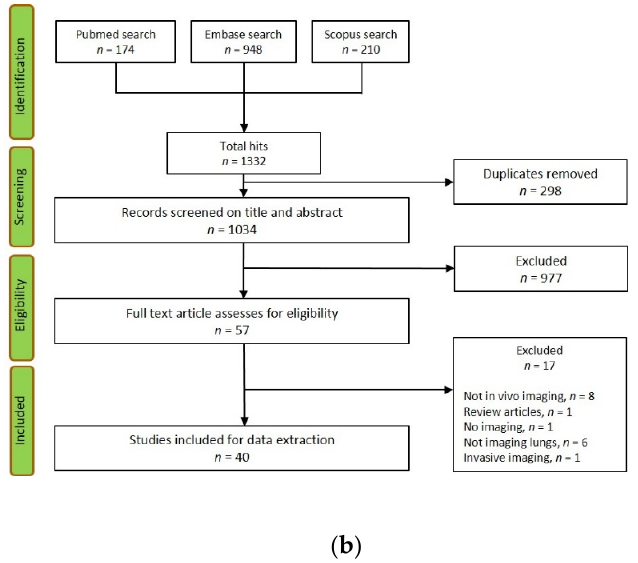
Figure 1. The flowchart of search hits and the different Preferred Reporting Items for Systematic reviews and Meta-analyses (PRISMA)-guideline selection phases, from the initial search ( a ) and the follow-up search ( b ), resulting in the total amount of 182 included articles.